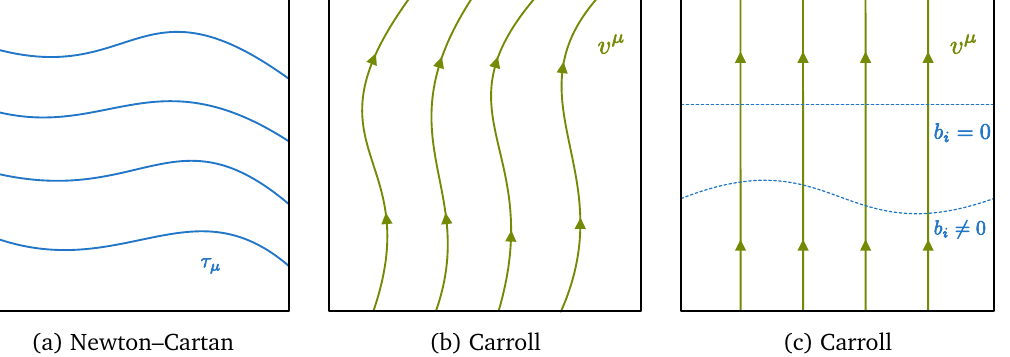
Figure 1: Foliation of spacetime in terms of a) spatial slices from τ µ in Newton– Cartan geometry, and b) timelike curves from v µ in Carroll geometry. In the latter case, using adapted coordinates as in c), we can still use τ µ to define coordinates in a fixed boost